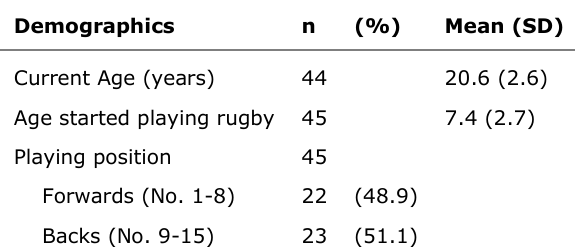
Table 2. Participants overall